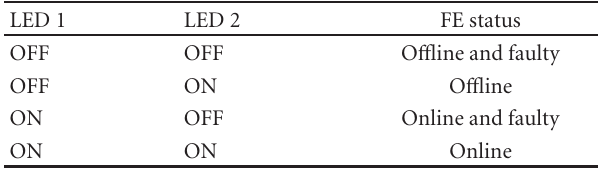
Table 5: FE status